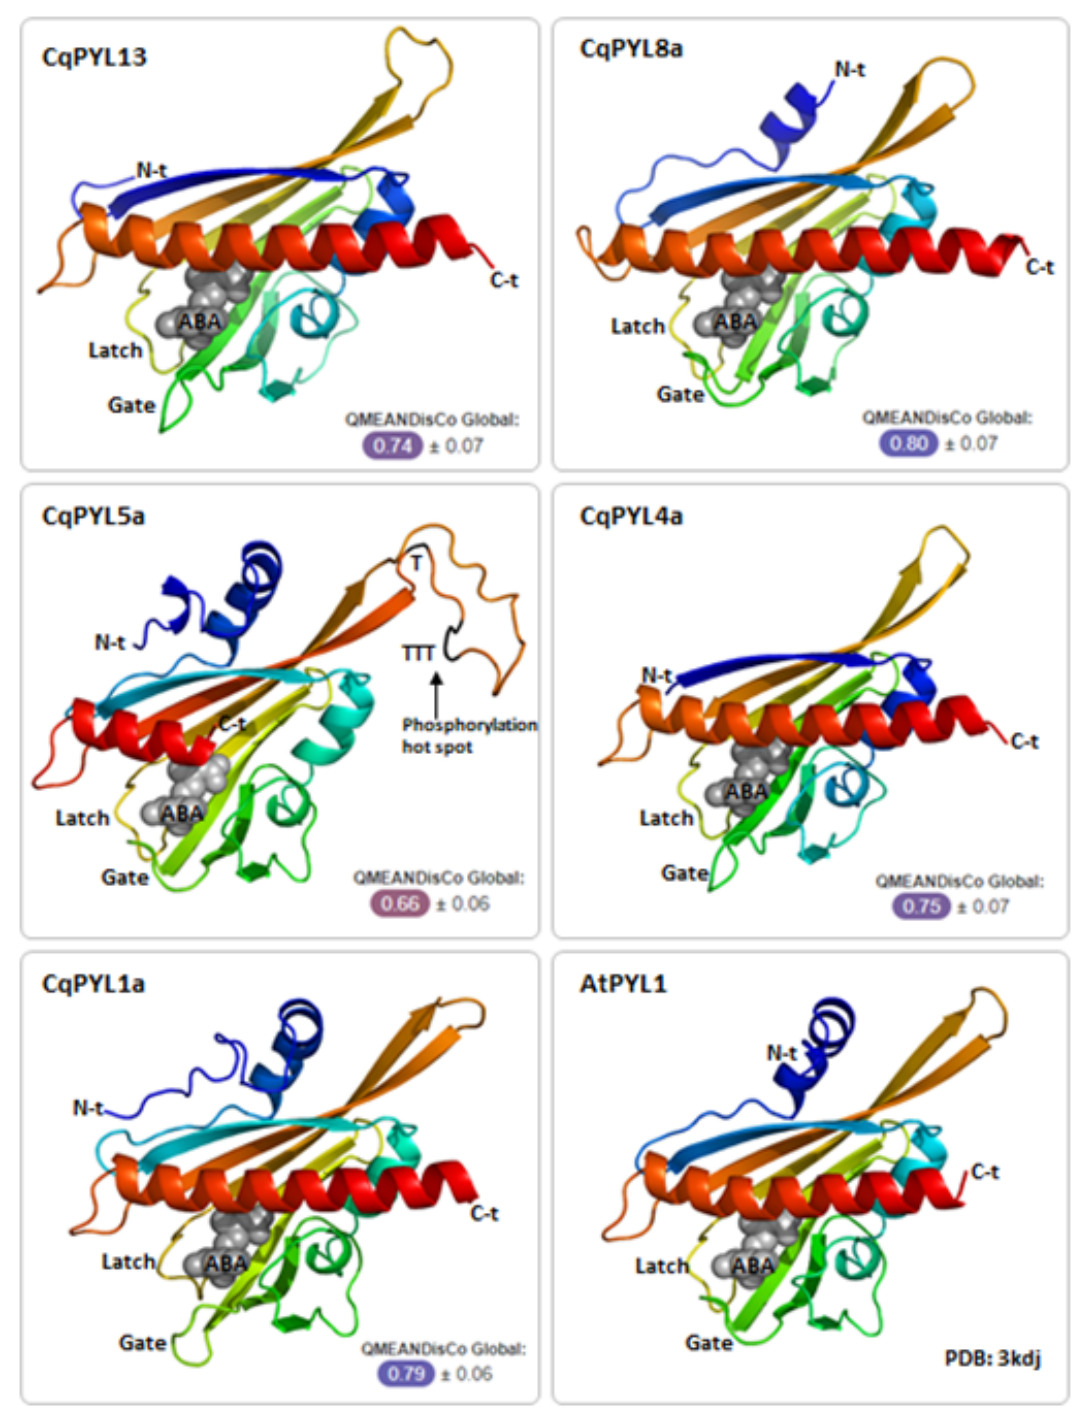
Figure 8. CqPYL 3D protein structure. CqPYLs topology were predicted by homology modeling using Swiss-Model and showed as cartoons using PyMOL. A quality estimation by QMEANDisCo global score was provided for each model. Gate and latch loops were indicated. ABA: abscisic acid; N-t: N-terminal domain; C-t: C-termonal